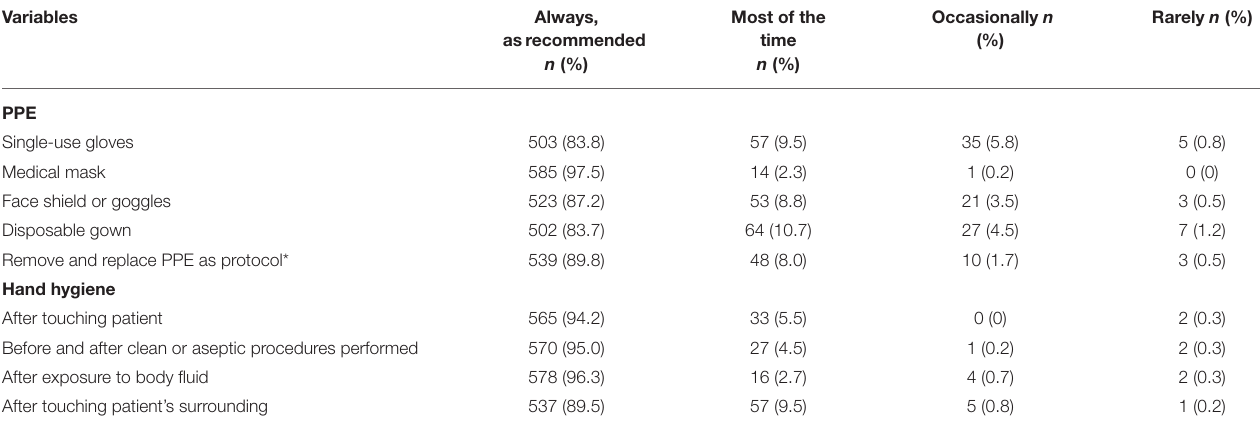
TABLE 1 | HCW adherence to infection prevention and control practices during interaction with patients with COVID-19. Variables Always,